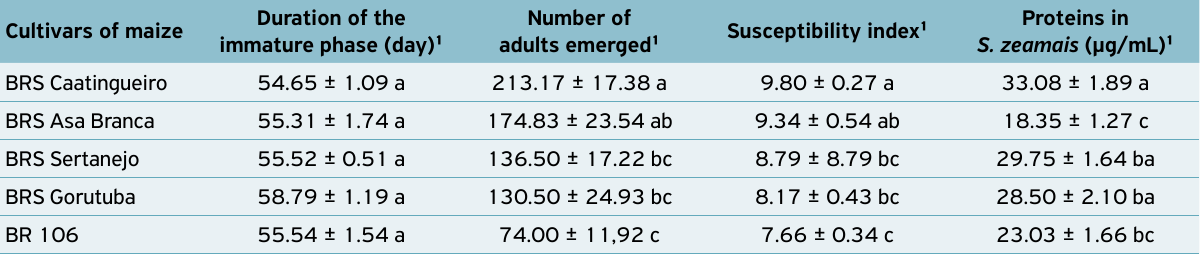
Table 1. Number (mean ± SE) of Sitophilus zeamais emerged, duration of the immature phase, susceptibility index and proteins in S. zeamais obtained after feeding on maize cultivars in no-choice test. Cultivars of maize